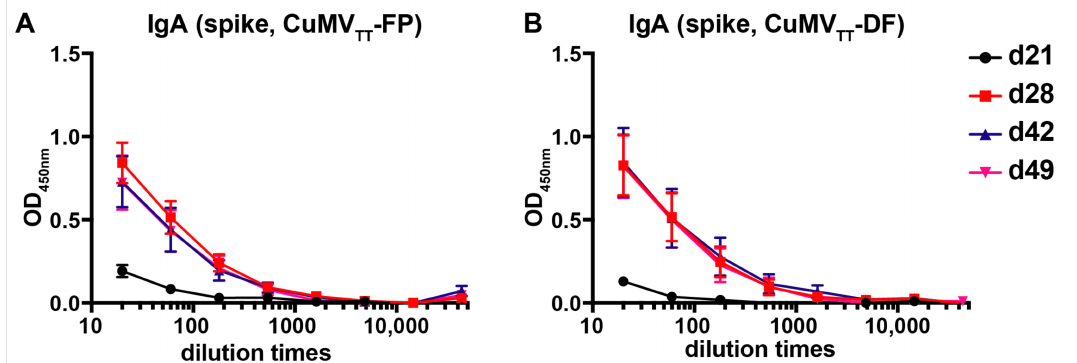
Figure 4. IgA antibodies in CuMV TT -FP ( A ) and CuMV TT -DF ( B ) immunized mice sera against spike protein ( n = 5) before and after booster immunization. Shown are curves of ELISA OD 450nm values according to serum dilution, mean ± SEM.